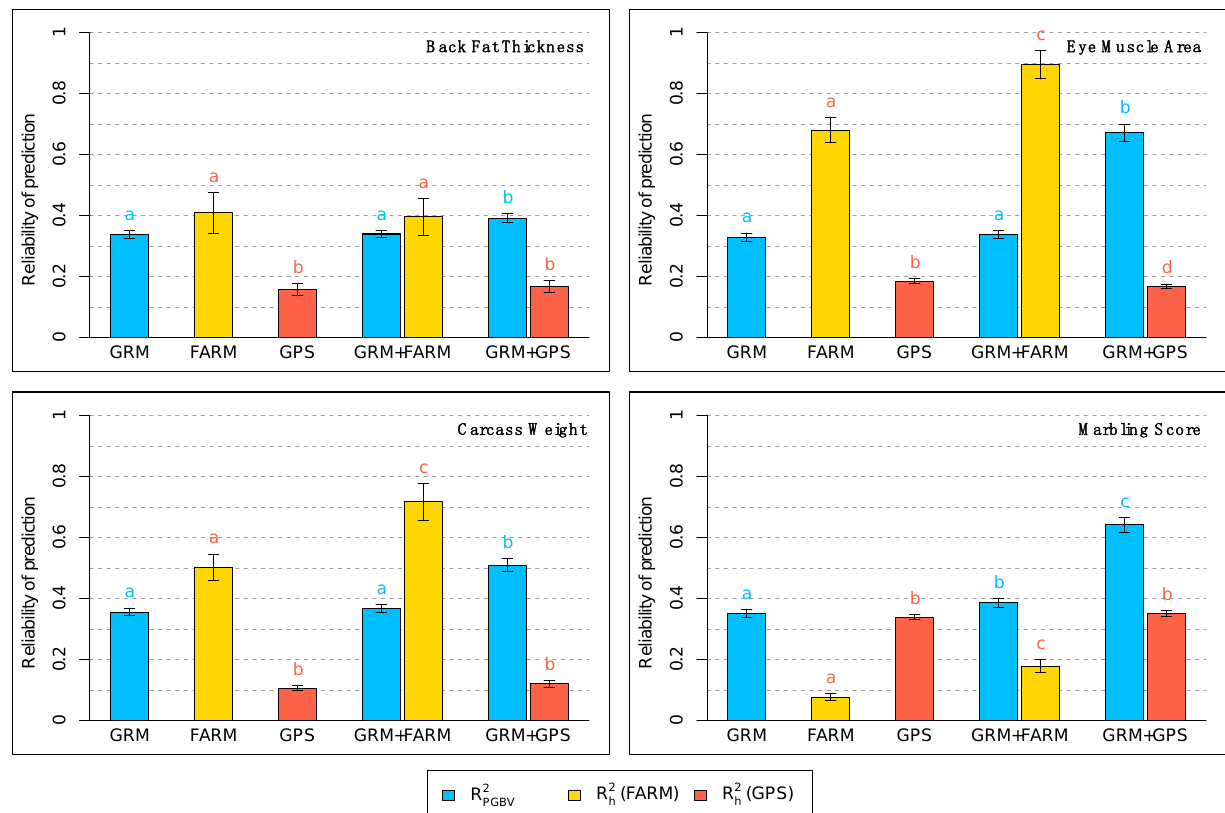
Figure 3. Reliability of predicted genomic breeding values ( 𝑅 𝑃𝐺𝐵𝑉2 = 𝑟 𝑃𝐺𝐵𝑉2 ℎ 2 ⁄ ), and reliability of predicted herd effects ( 𝑅 𝜂2 = 𝑟 𝜂2 𝑒 2 ⁄ ), for all four traits and all the five models considered. The heights of the barplots in this figure represent the mean over 100 replicates of each model, with their confidence intervals indicated. Letters a, b, c, d indicate the groups obtained with Tukey’s multiple comparison test at a significance level of 0.05, comparing the values of 𝑅 𝑃𝐺𝐵𝑉2 (blue letters) and of 𝑅 𝜂2 (red letters) obtained with the different models, within each trait.